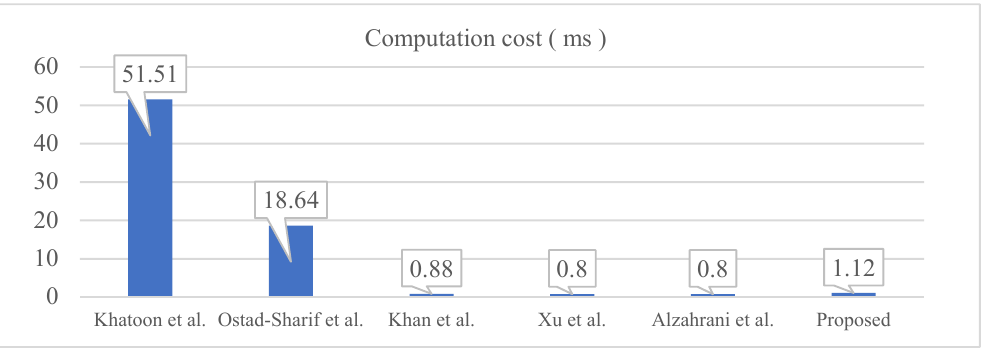
Figure 5. Computation cost comparison.